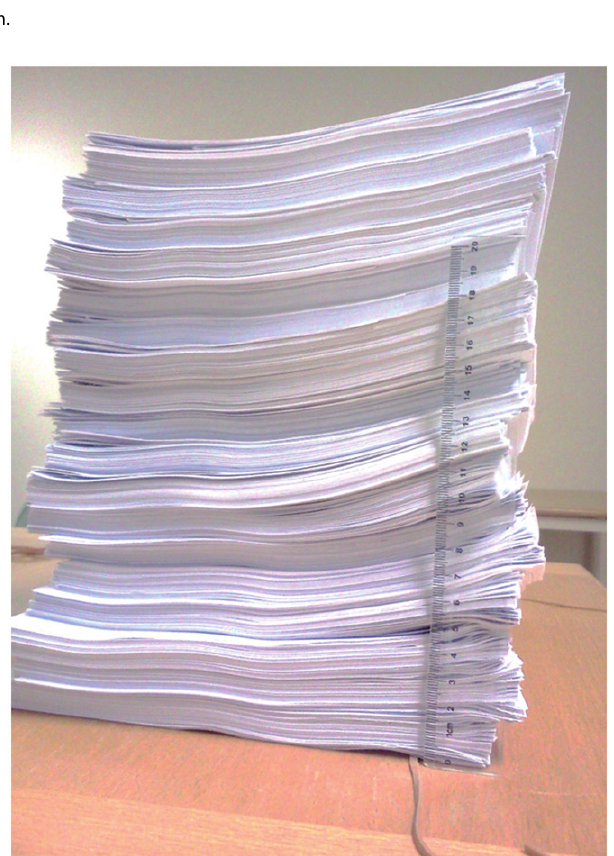
Figure 2. Resubmission to the ethics review